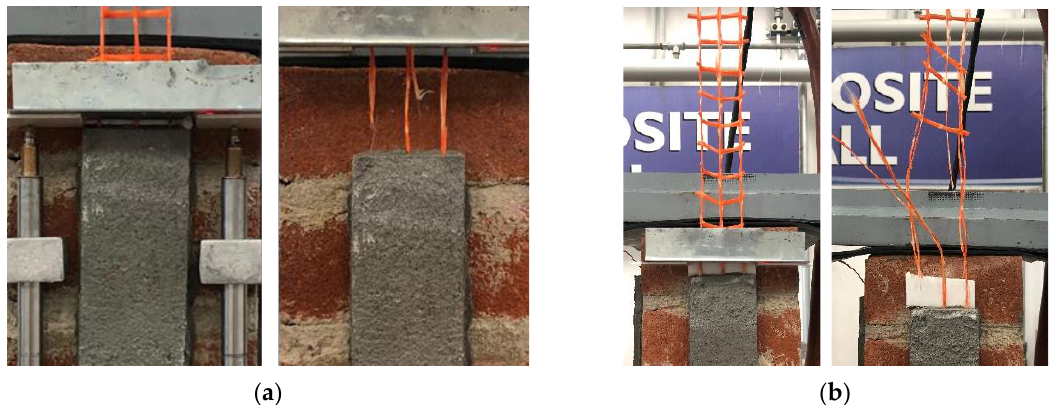
Figure 10. MD mf R failure ( a ) within the bonded length (specimen DS_300_50_G_W/D_1) and ( b ) outside the bonded length (specimen DS_300_50_G_W/D_2).